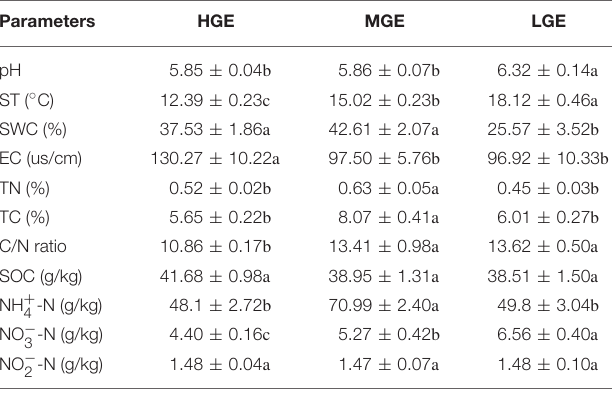
TABLE 1 | Description of soil physicochemical parameters among three elevational gradients.